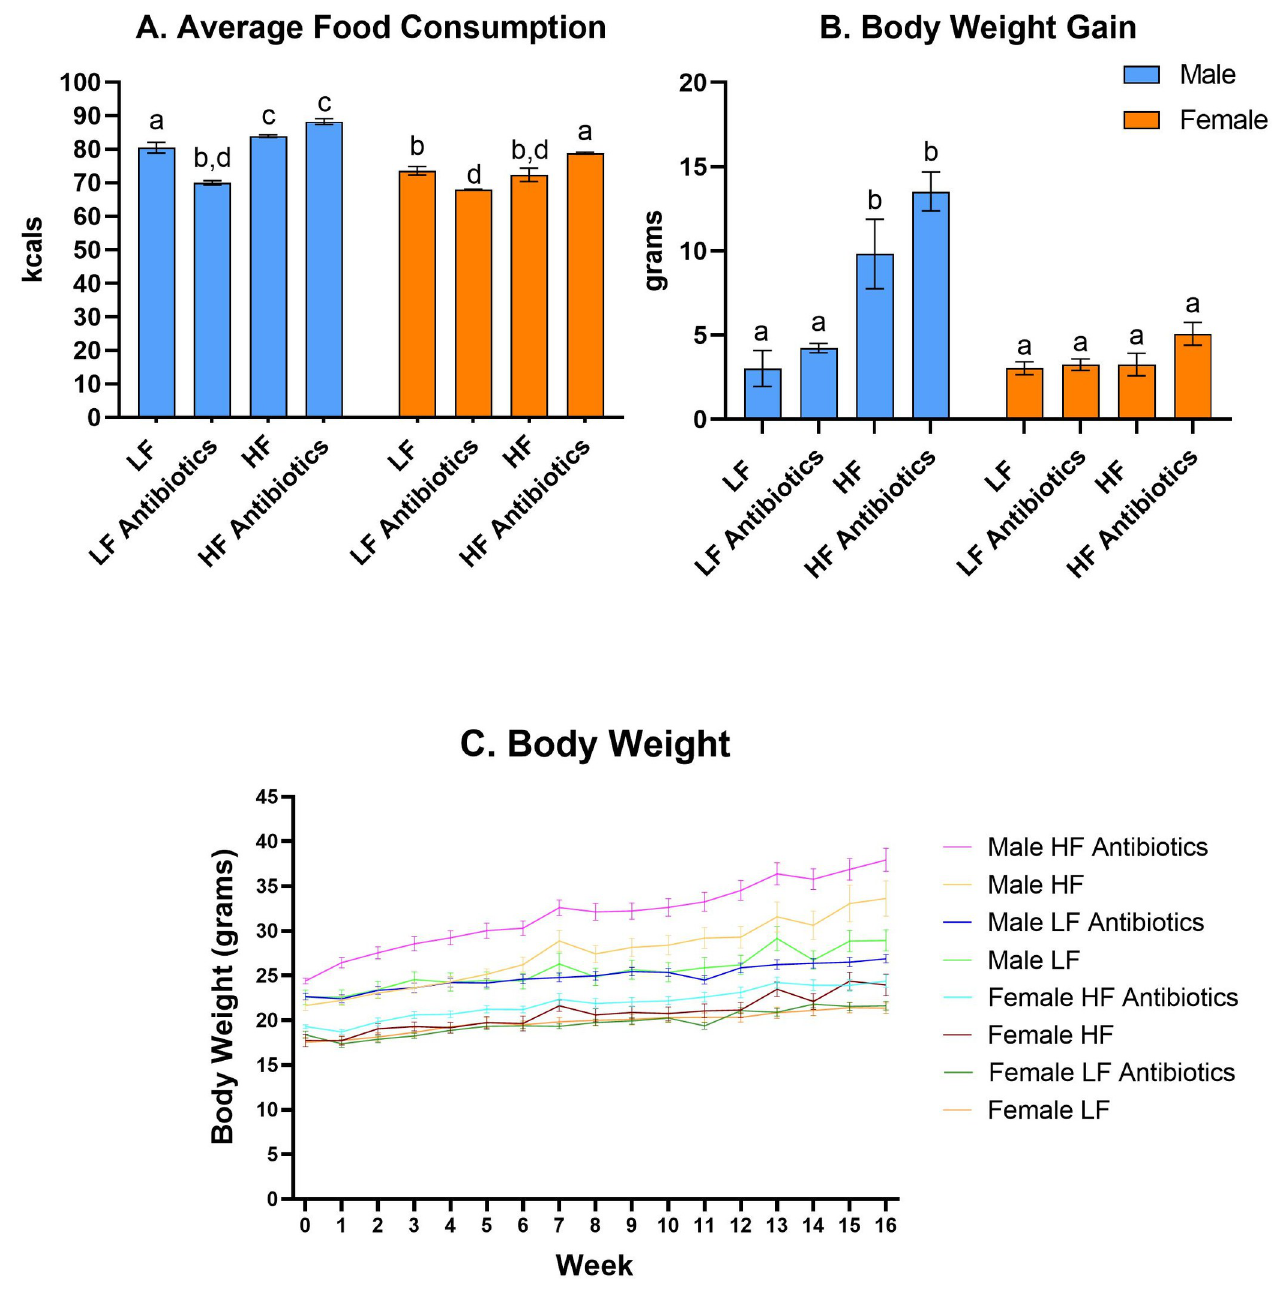
Fig 1. Average food consumption and body weight during the 16-week dietary study. (A) Average food consumption for the entire 16-week study. Different letters indicate groups that are significantly different (p < 0.05). (B) HF-fed mice gained significantly more weight than LF-fed mice. Male HF and Male HF Antibiotics gained significantly more weight than all other groups. (C) Male HF Antibiotics reveal the highest body weight; Female LF and Female LF Antibiotics reveal the lowest body weight. Values shown are mean ±